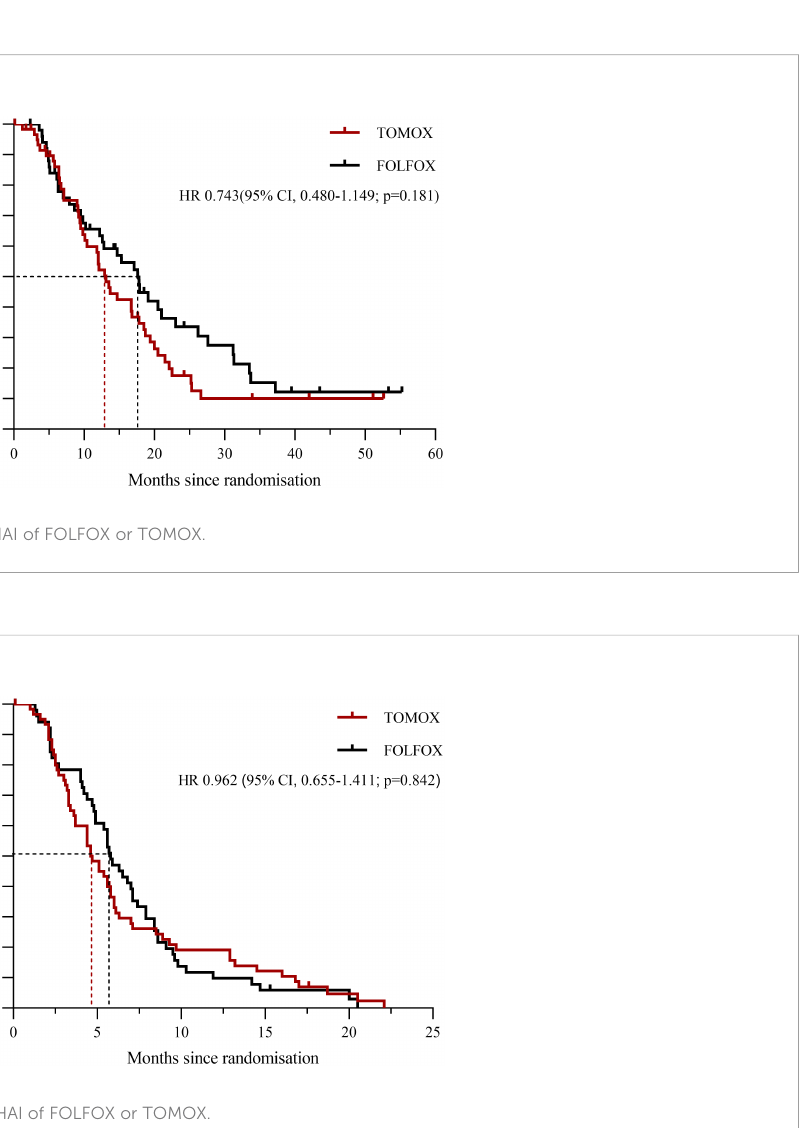
TABLE 2 Response rates to HAI of TOMOX or